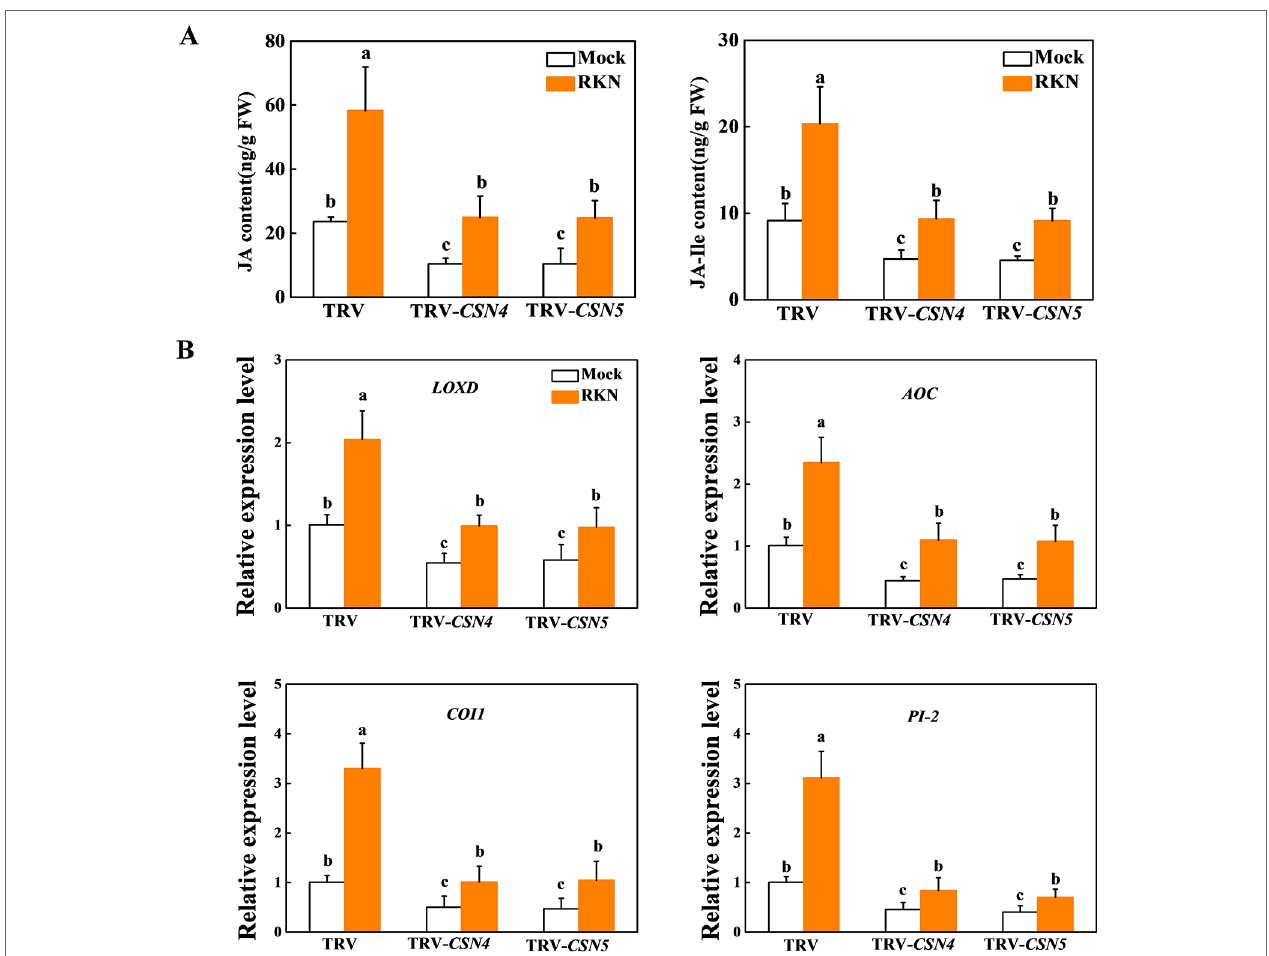
FIGURE 5 | The contents of endogenous jasmonic acid (JA) and JA-isoleucine (Ile) and the transcription levels of JA-related genes in CSN4 - or CSN5 -silenced tomato lines. (A) The contents of endogenous JA and JA-Ile were analyzed by high-performance liquid chromatography–tandem mass spectrometry (HPLC-MS/ MS) in tobacco rattle virus (TRV) control, CSN4 - or CSN5 -silenced roots at 24 h after infection with Meloidogyne incognita . (B) The transcription levels of JA-related genes LOXD , AOC , COI1 , and PI-2 in tomato roots 24 h after infection with M. incognita . The data shown are the average of three biological replicates, with the standard errors shown by vertical bars. Means denoted by the same letter did not significantly differ at P < 0.05, according to Tukey’s